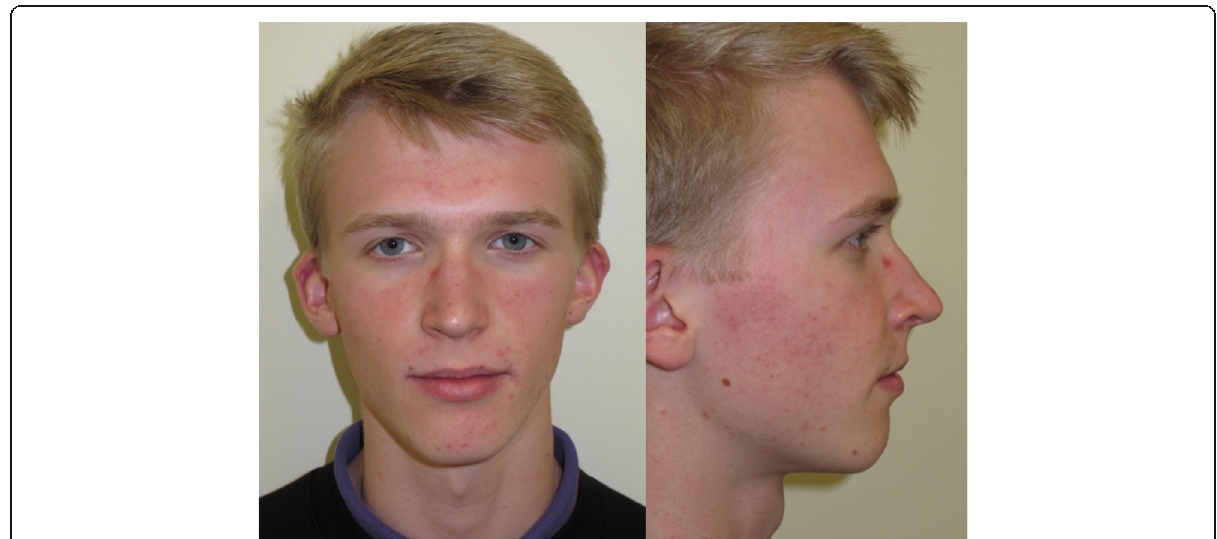
Fig. 12 Facial photograph views at 22-month